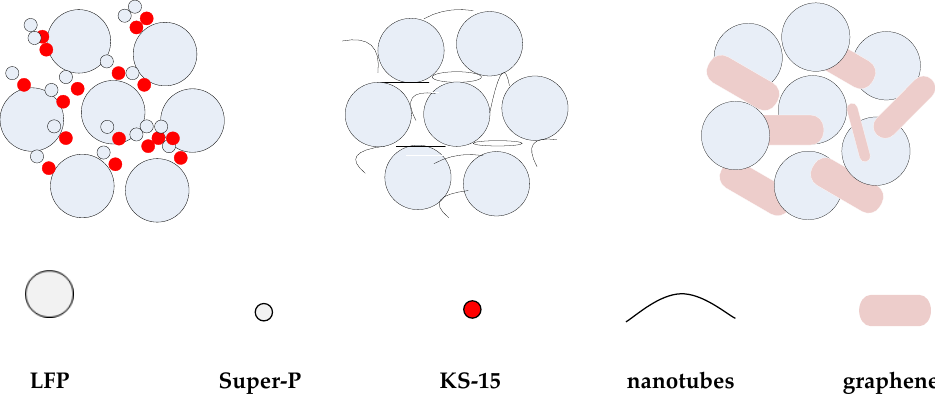
Figure 3. The contact model of electroactive materials and conductive agents.